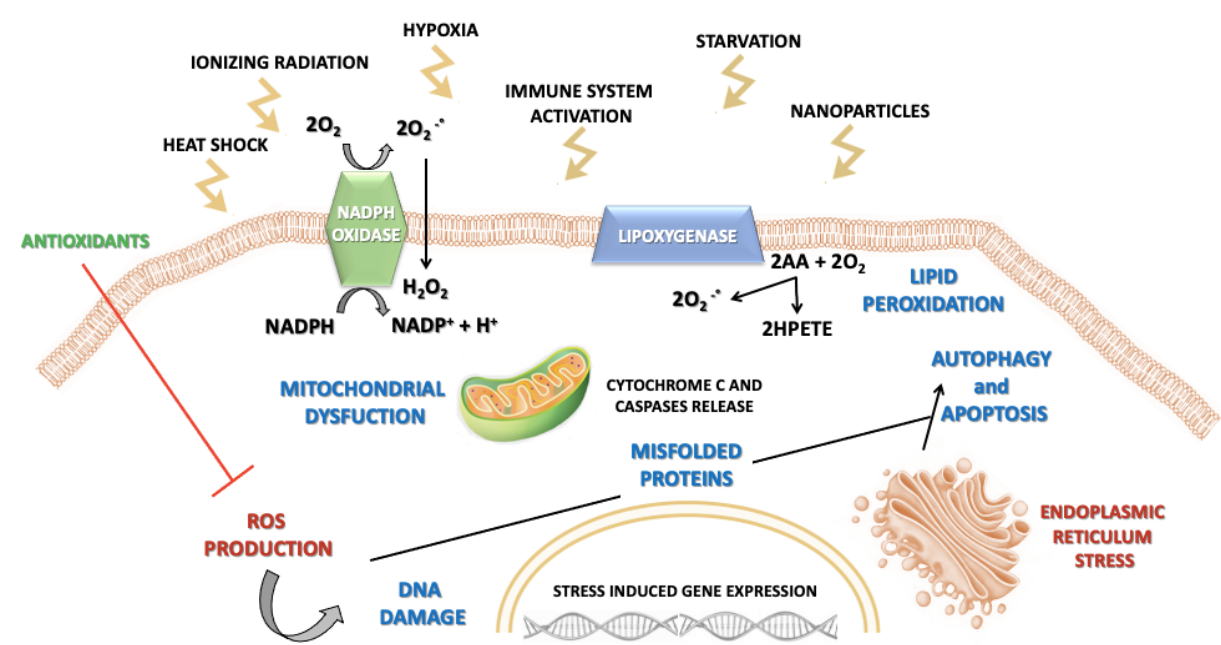
Figure 1. Schematic illustration of various triggers responsible for reactive oxygen species (ROS) generation and ROS- induced pathways leading to cell